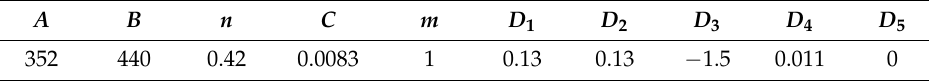
Table 2. Johnson Cook model parameters for AA2024-T351 (data from